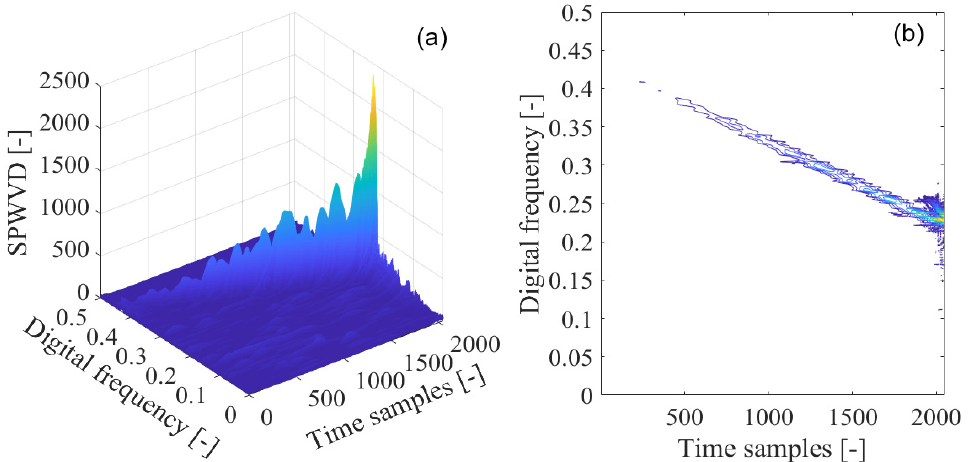
Figure 14. The smoothed pseudo-Wigner–Ville distribution (SPWVD) of the GPS L1-C/A signal disturbed by the sweep interference; ( a ) SPWVD; ( b ) SPWVD’s contour.